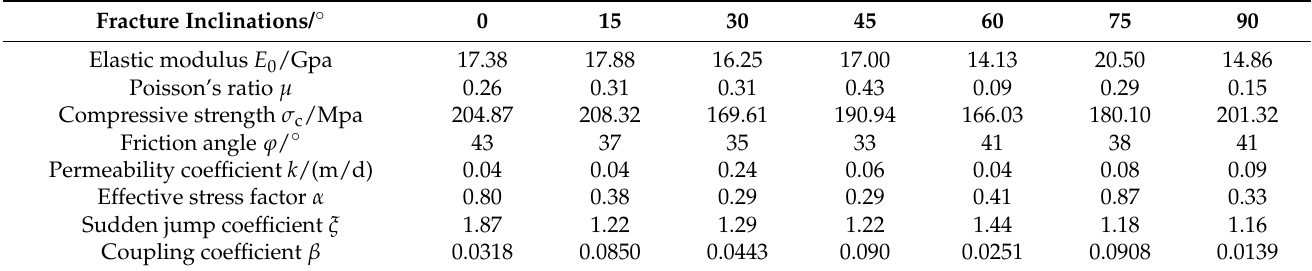
Table 2. Hydro-mechanical coupling micromechanics and seepage